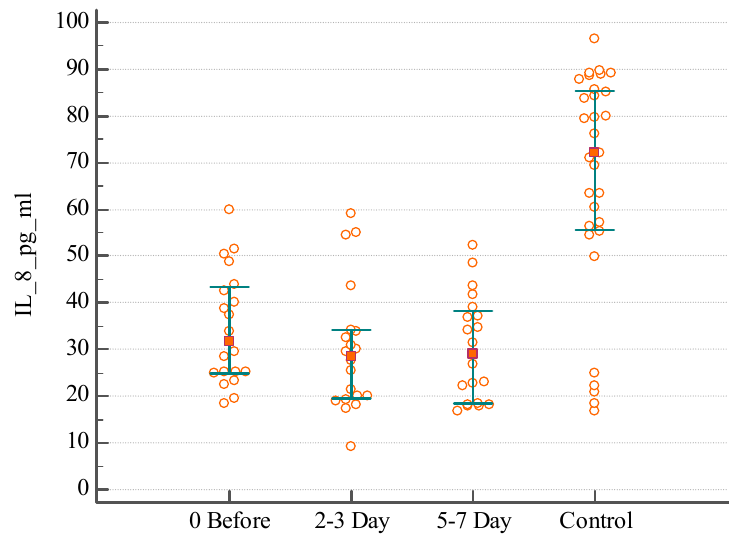
Figure 3. The distribution of serum IL-8 level in patients with diffuse peritoneal collection due to intra-abdominal infections before, and on the 2nd–3rd and 5th–7th days after surgical intervention.